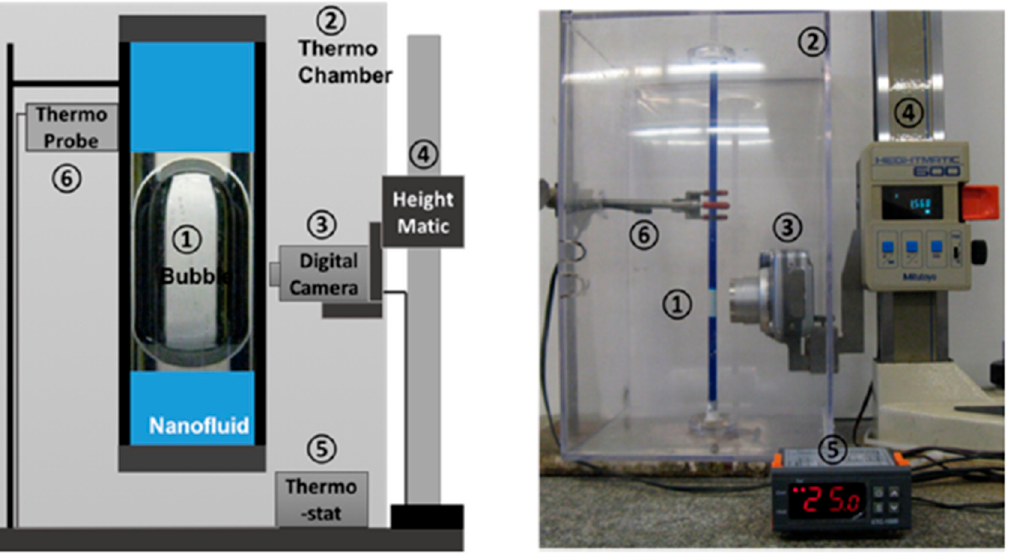
Figure 4. Schematic of the setup to monitor the rising bubble in a nanofluid in a vertical tube. The setup is as follows: 1, bubble; 2, thermo chamber; 3, camera; 4, heightmatic; 5, thermostat; 6, thermoprobe. Reprinted with permission from [34]. Copyright 2017 American Chemical Society.